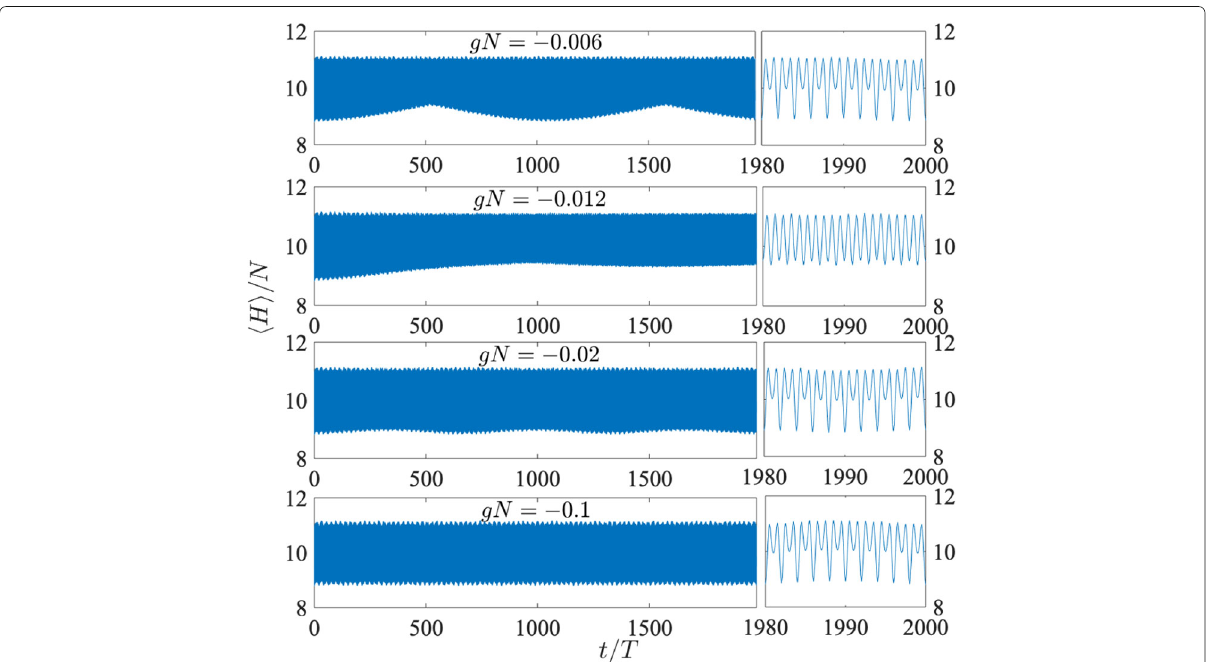
Fig. 2 Mean energy of the atoms (i.e., the sum of the kinetic energy, the potential energy in the gravitational field and the interaction energy) which are released from a harmonic trap and start bouncing on the oscillating mirror along the 2 : 1 ( s = 2) resonant trajectory. The presented results are obtained within the TWA for N = 600 [54] and they correspond to the interaction strength g 0 N close to the critical value ( g 0 N = − 0.012 [55]) for the formation of a DTC and deep in the DTC regime ( g 0 N = − 0.1). In all the cases, there is no signature of heating. Reprinted from [54]